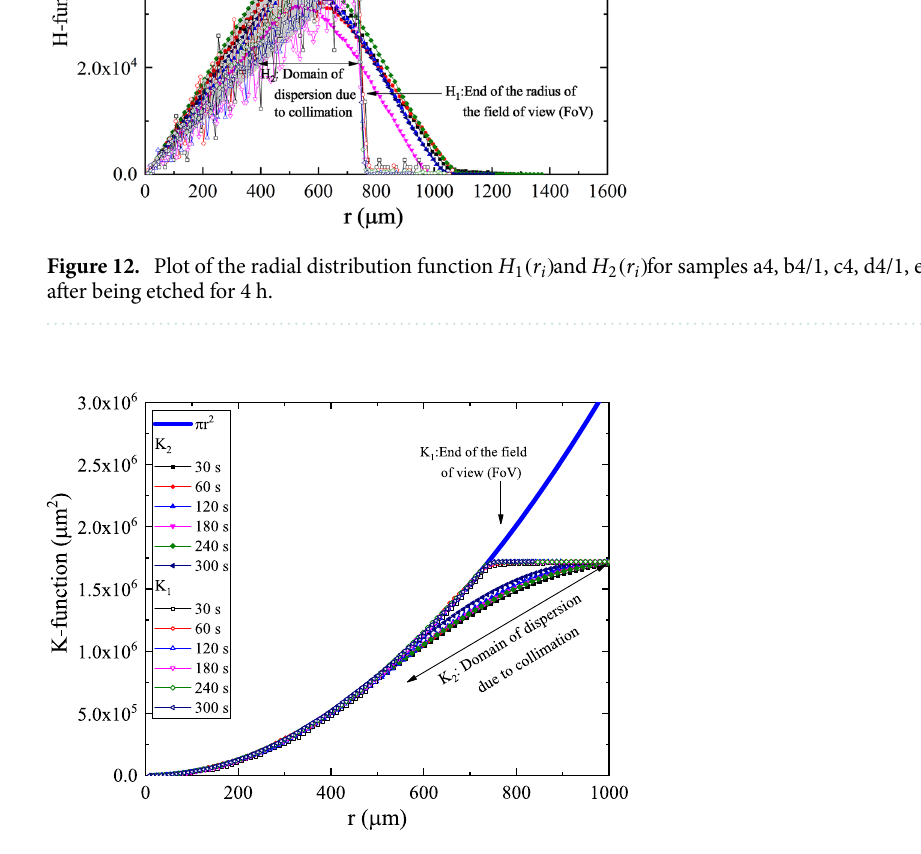
Figure 13. Plot of the cumulative radial distribution function K 1 ( r ) and K 2 ( r ) for samples a2, b2, c2, d2, e2, and 2 f2. The values of π r were added for